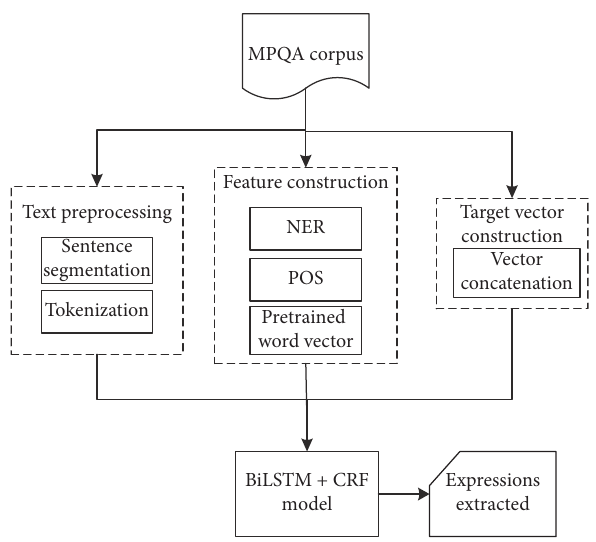
Figure 2: Elements extraction flow of opinion